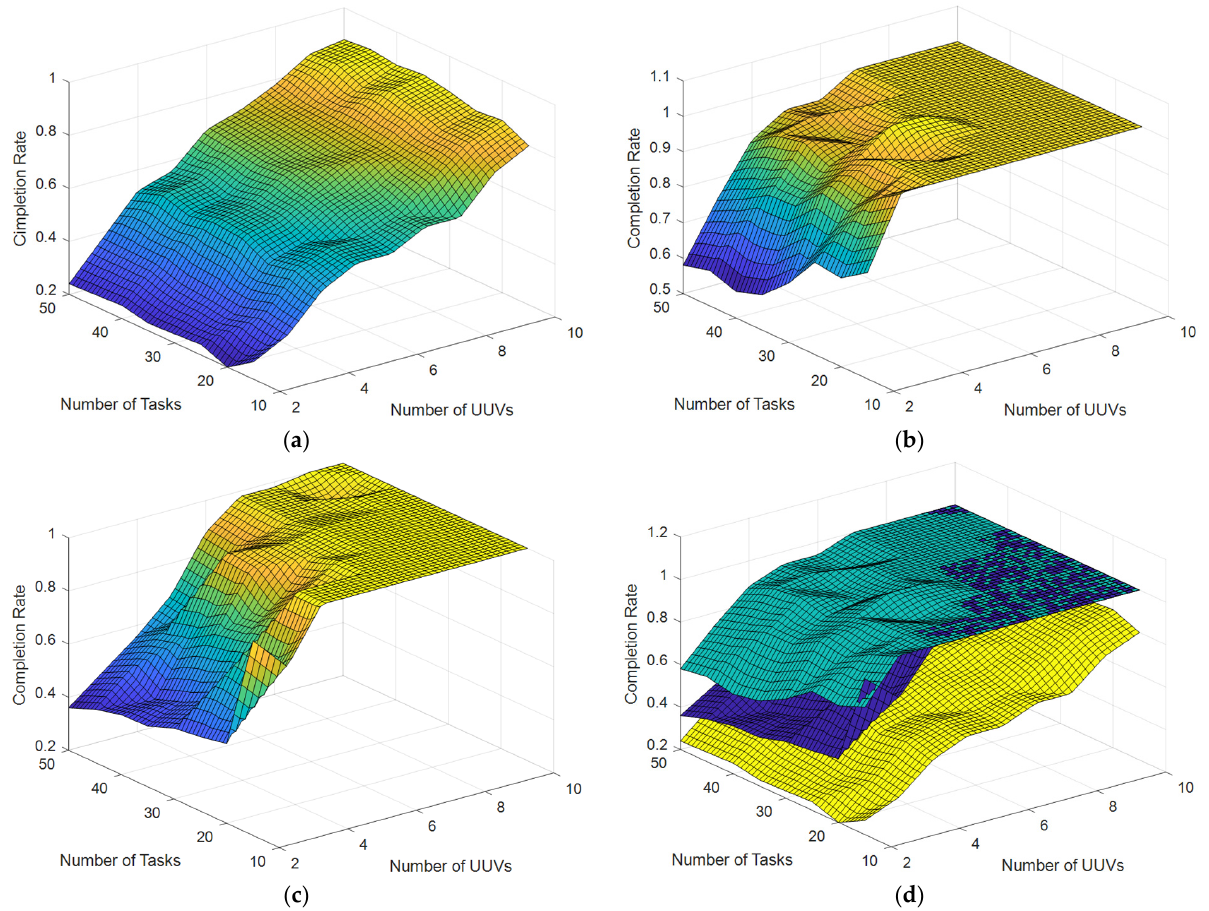
Figure 7. Completion rate with different numbers of UUVs and tasks. ( a ) Original CBBA (without communication range constraint). ( b ) ECBBA (without communication range constraint). ( c ) DECBBA (with communication range constraint). ( d ) Comparison of Three Algorithms.